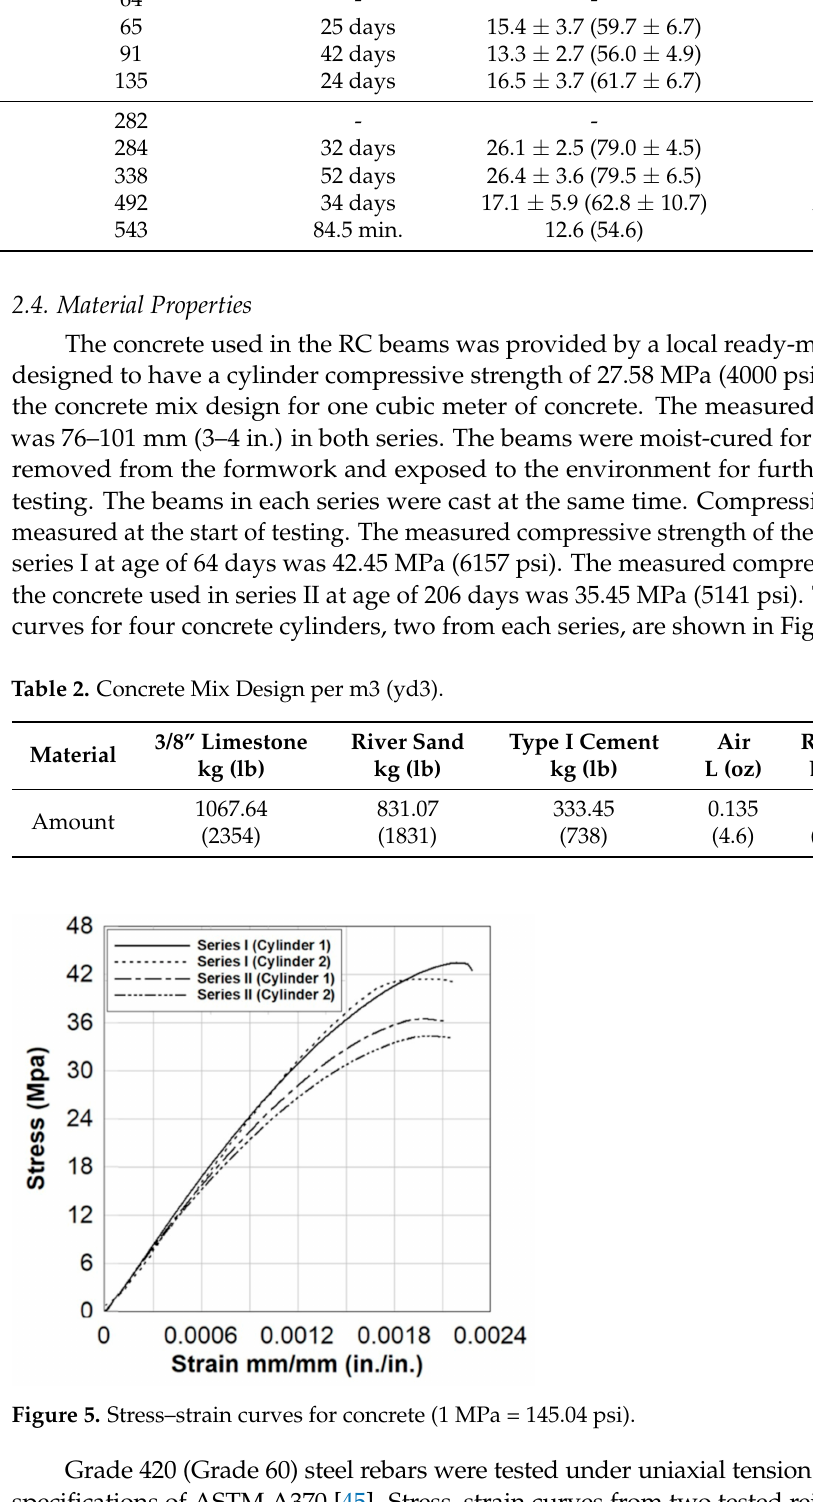
Figure 6. Stress–strain curves for longitudinal reinforcement. 2.5. Testing Procedure Sustained load specimens were first loaded to a target sustained load within about 20 min (short-term loading). Then, the load was held constant for 24 to 52 days (sustained loading). The target sustained window was 24 days. Although this testing period may seem short for creep testing, the objective of this research was to determine if failure would occur under high sustained load. After 24 days, the rate of deflection increase re- duced to less than 0.025 mm/day (0.001 in./day) on average and the research team felt the beam would not fail under additional testing. This was verified by a few specimens that were tested for an extended time period to evaluate behavior beyond 24 days. The applied